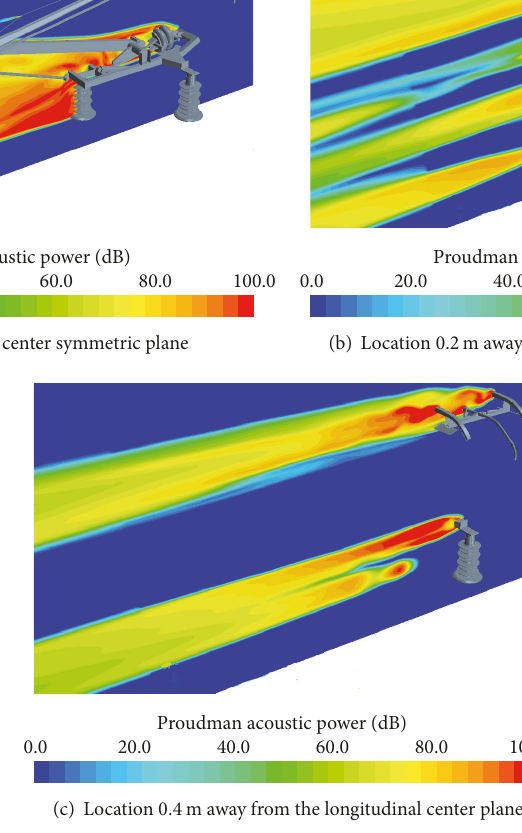
Figure 11: Distribution of quadrupole noise sources for